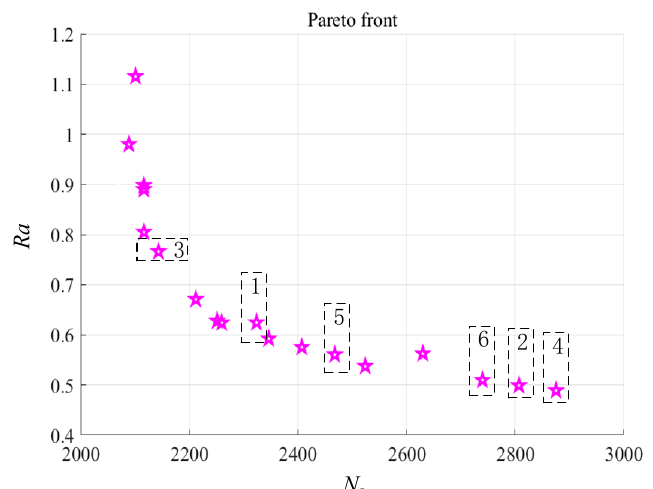
Figure 20. Pareto frontier obtained by multi-objective genetic algorithm (MOGA).